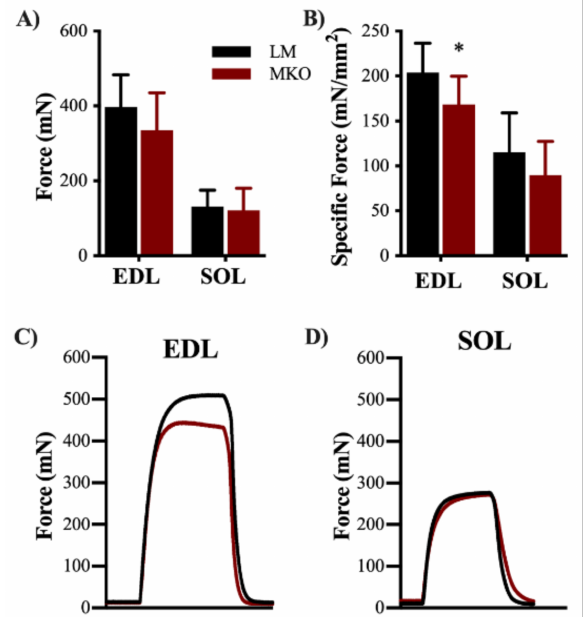
Figure 2. Ulk1 deficiency predominately affects fast-twitch muscle fibers strength. ( A ) Average in vitro maximum contraction force from both extensor digitorum longus (EDL) and soleus (SOL) muscles ( p > 0.05) ( B ) Average specific force from both EDL and SOL muscles ( p = 0.0277, and p = 0.2371, respectfully). Representative torque tracing from ( C ) EDL and ( D ) SOL muscles. All data are presented as mean ± SD n = 10 mice. * = Significantly different from LM.